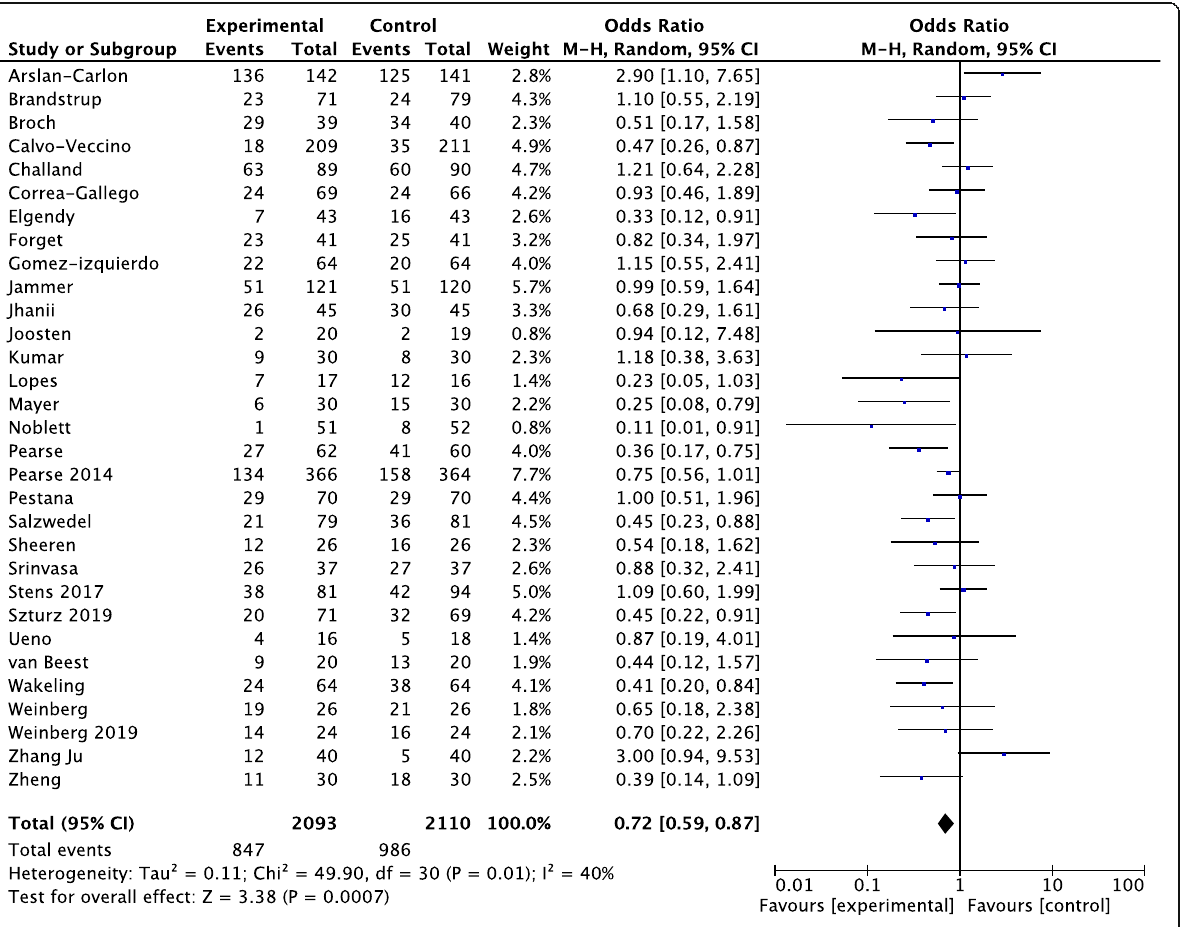
Fig. 3 Rates of postoperative complications in patients undergoing abdominal surgery, with odds ratios (ORs) and 95% confidence intervals (CI). The pooled OR and 95% CI are shown as the total. The size of the box at the point estimate of the OR gives a visual representation of the “ weighting ” of the study. The diamonds represent the point estimate of the pooled ORs and the length of the diamonds is proportional to the